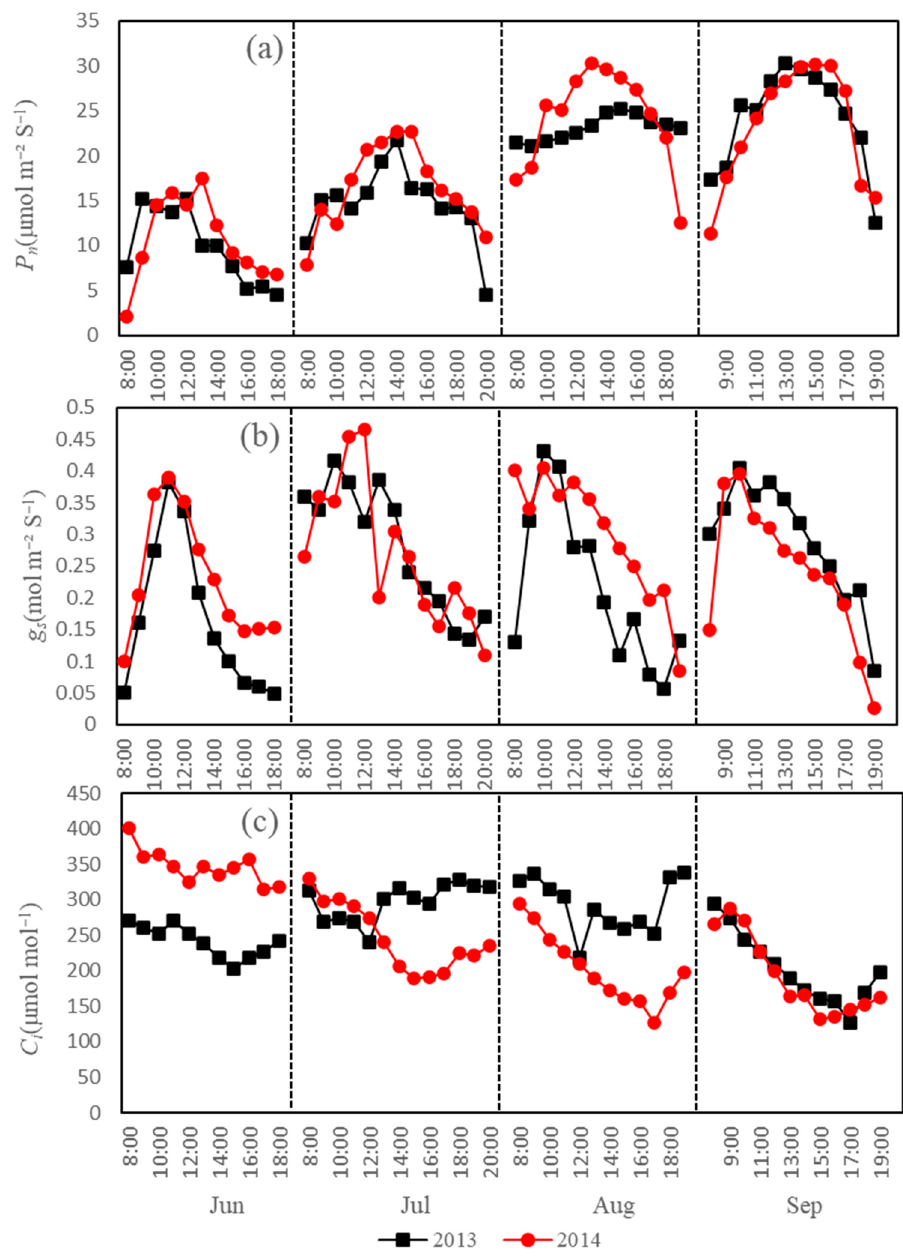
Figure 3. Diurnal variations in ( a ) net photosynthetic rate ( P n ), ( b ) stomatal conductance ( g s ), and ( c ) intercellular CO 2 concentration ( C i ) during the main growing seasons of Populus euphratica in 2013 and 2014. The values in the figure are averages for each parameter at the same hour on different observational days in each month. Table 2. Pearson coefficients between environmental parameters and net photosynthesis ( P n